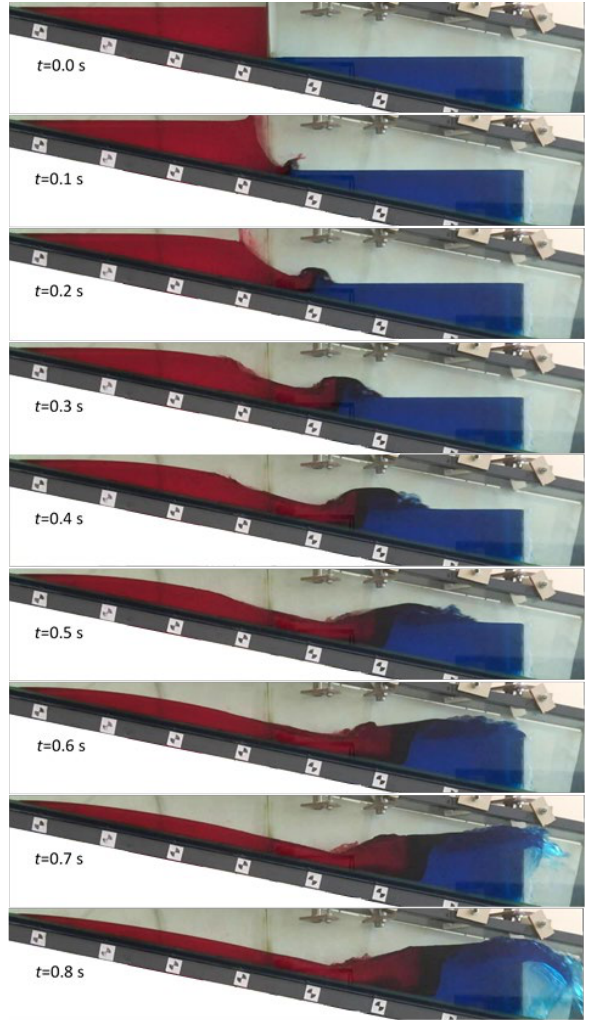
Figure 6. Initial and development stages of the dam-break flow.